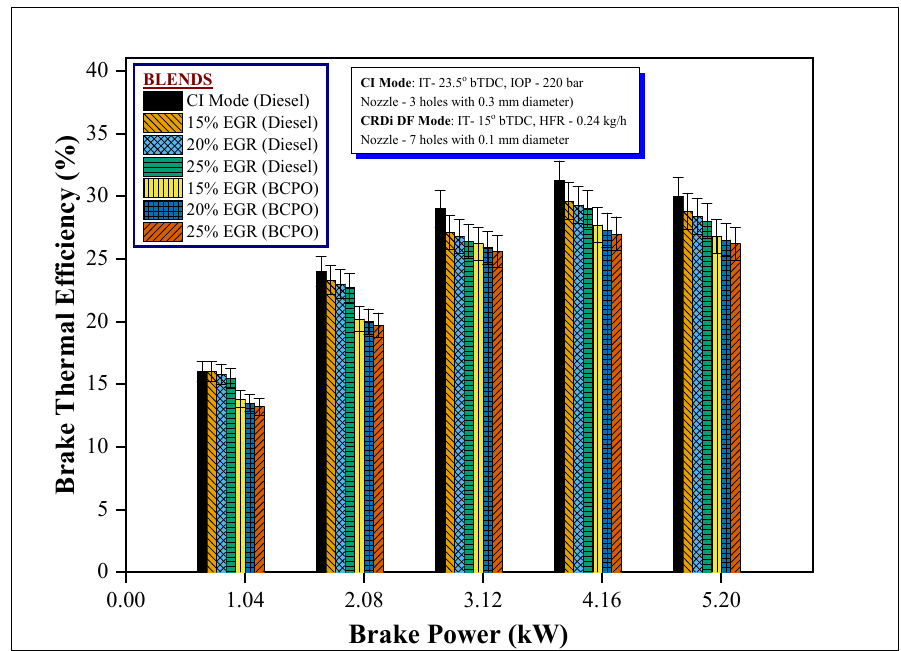
Figure 13. EGR and BP influence on CRDi engine BTE.